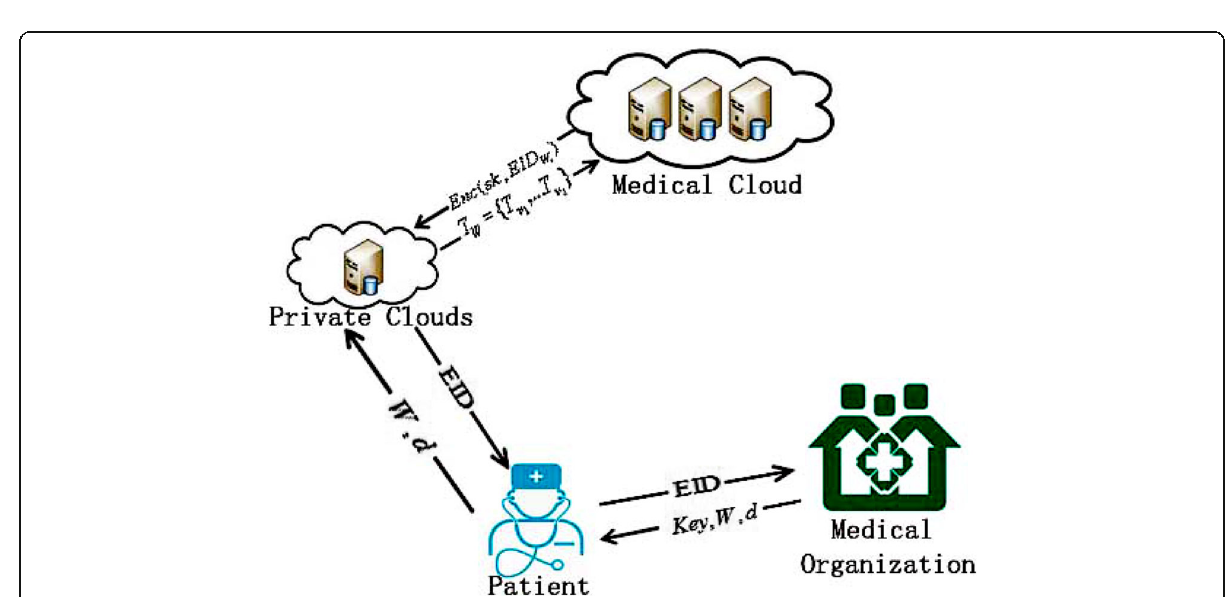
Fig. 5 A keyword blur search for other